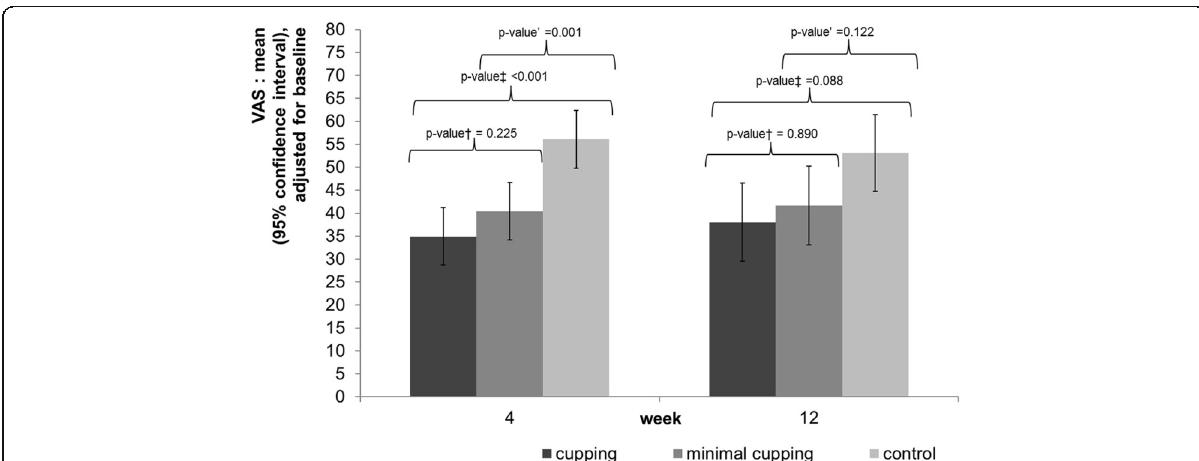
Fig. 3 Pain intensity measured by Visual Analogue Scale at 4 and 12 weeks. Legend Fig. 3: VAS, 0 – 100 mm; 0 = no pain, 100 mm = maximum intensity † low vacuum vs high vacuum, ‡ control vs high vacuum, ‘ control vs low